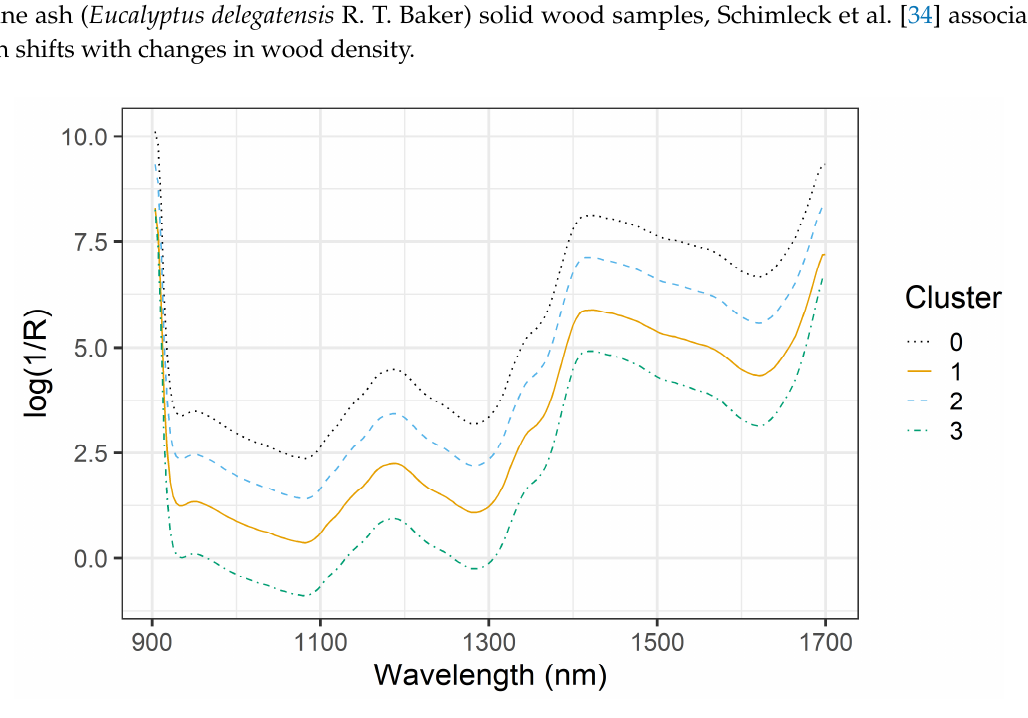
Figure 3. Average NIR spectra for each cluster.